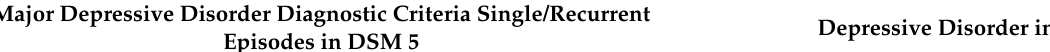
Table 1. Diagnostic criteria of depression according to ICD 11 and DSM 5